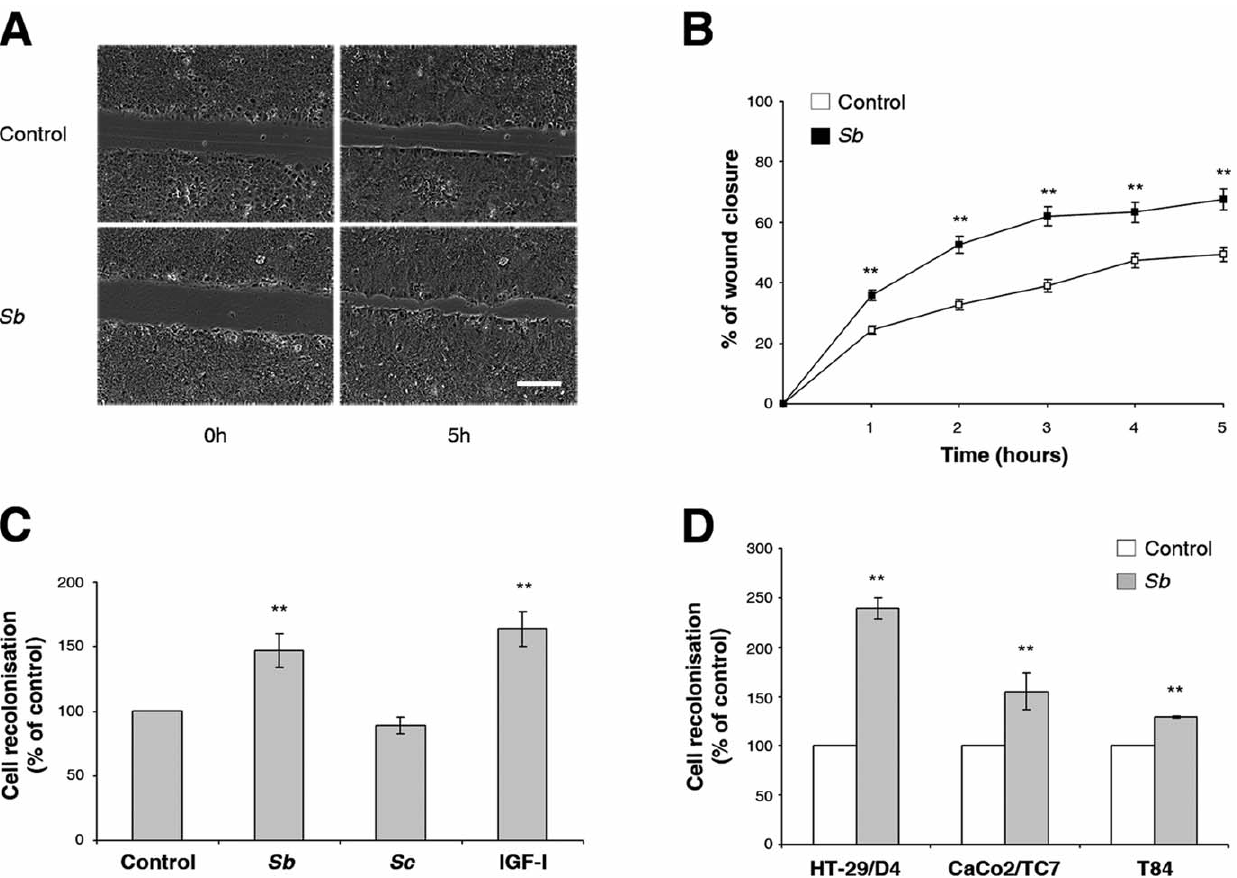
Figure 1. Sb increases intestinal epithelial cell restitution. ( A ) Polarized HCT-8/E11 cell monolayers were wounded as described in Methods and incubated for 5 hours with or without Sb supernatant. Phase contrast images were acquired at the indicated times (see also Supplementary